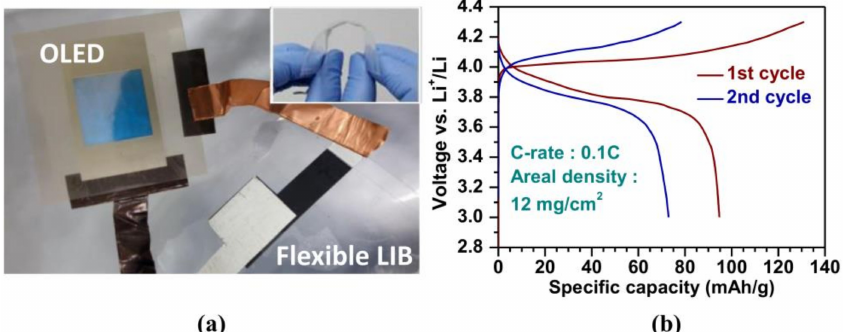
Figure 4. ( a ) Digital photo of a Flexible LIB cell that illuminates a blue Organic Light Emitting Diode (OLED) at 4 V; Inset: flexibility of the LIB cell under bending; ( b ) galvanostatic charge and discharge curvefor the flexible LIB cell. Reproduced from reference [138] under CC BY 4.0